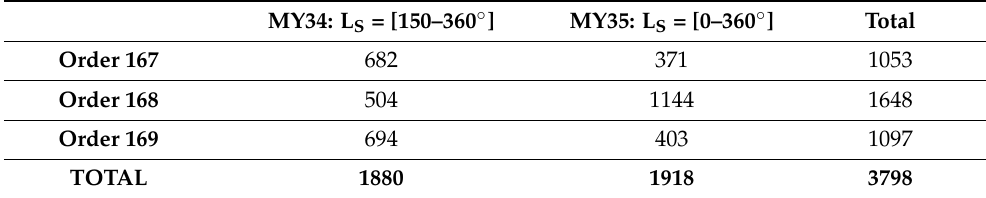
Table 1. Number of LNO orbits through the 3 orders close to the 2.7 µ m ice absorption band (i.e., 169, 168, and 167) in MY34 (starting at L S = 150 ◦ which is the beginning of the NOMAD science phase) and